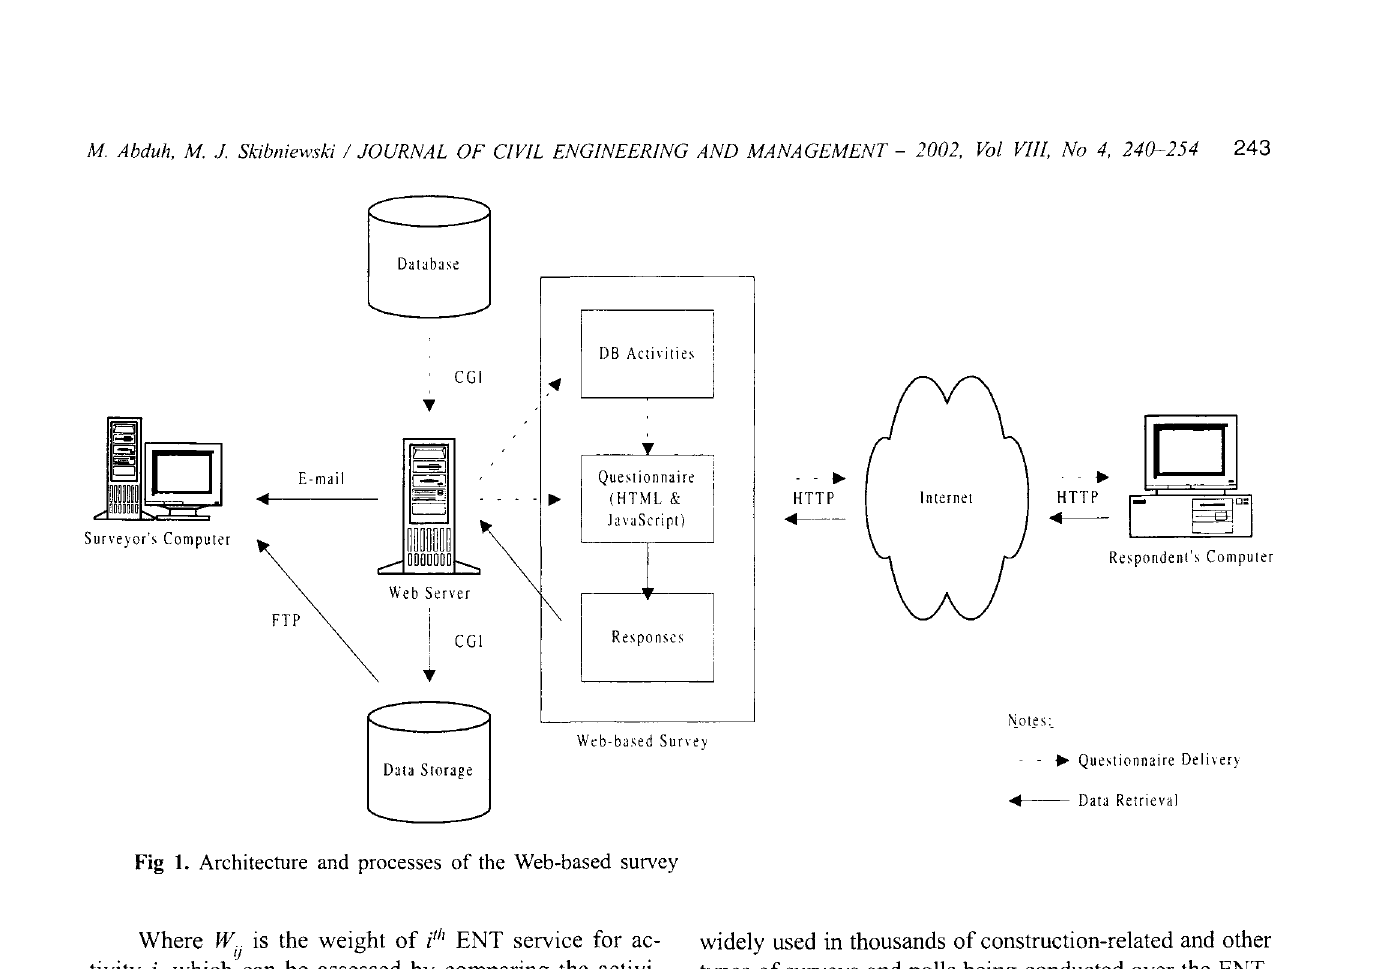
Fig 1. Architecture and processes of the Web-based survey